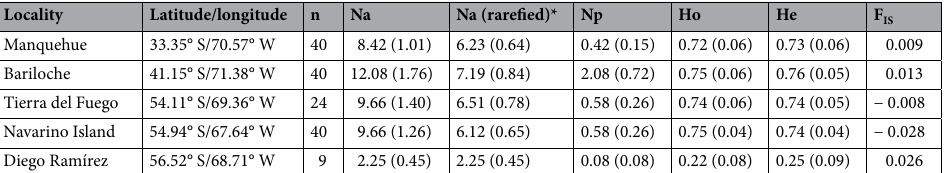
Table 2. Localities, sample sizes and measures of genetic diversity based on 12 microsatellite loci in five Aphrastura populations. N sample size, Na number of alleles, Np number of private alleles, Ho observed heterozygosity, He expected heterozygosity, F IS within-population inbreeding coefficient. Mean values and standard errors over 12 microsatellite loci are reported. *The allelic richness for the minimum number of individuals genotyped in any population (times